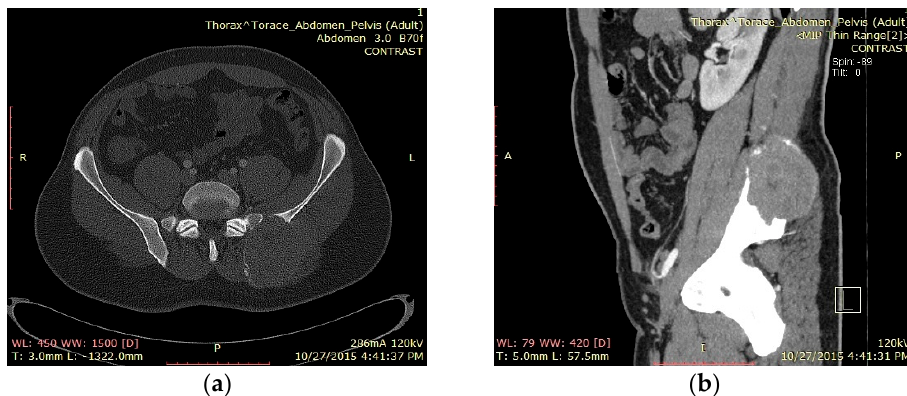
Figure 3. Case 3. ( a ) Preoperative axial T2MRI indicating a left side posterior iliac tumoral mass with